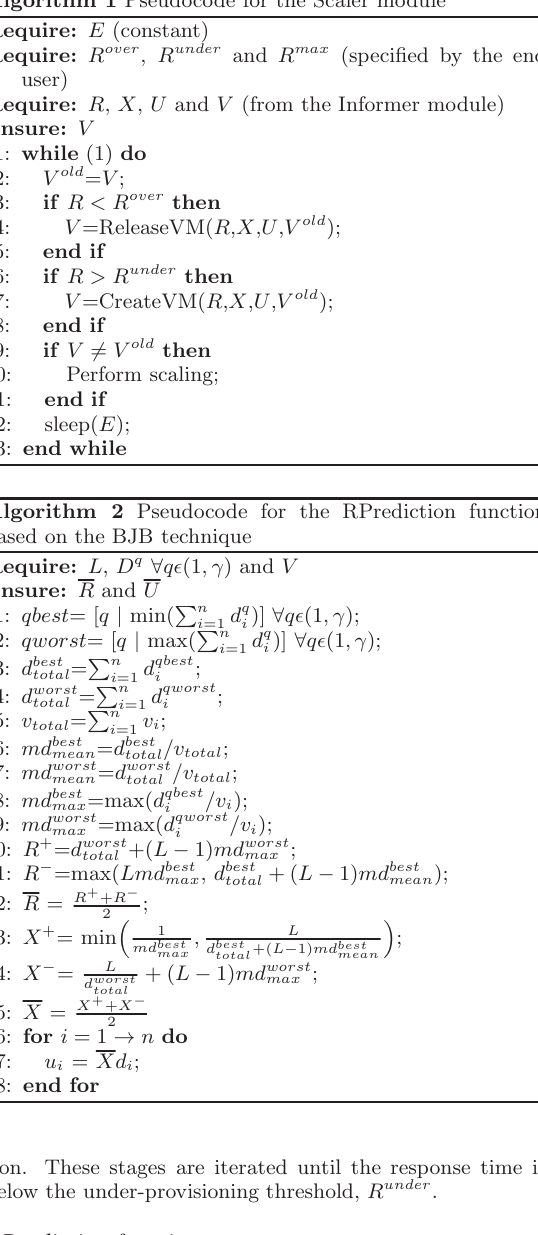
Algorithm 1 Pseudocode for the Scaler module